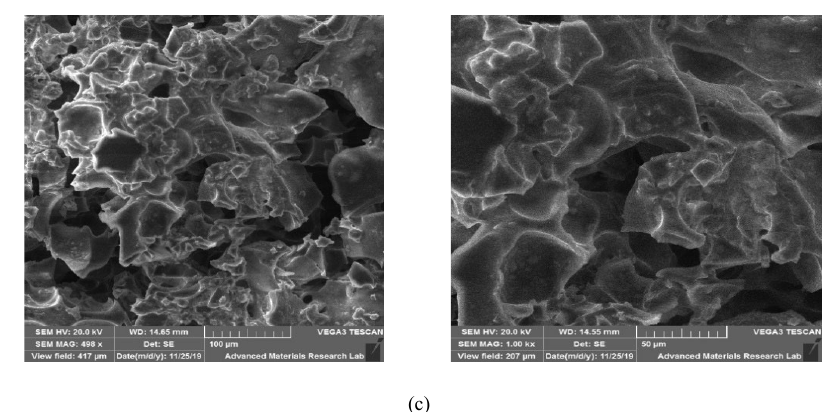
Fig. 4. SEM images (left side: 500×; right side: 1000×) of a) coffee waste; b) bio-char; c) activated